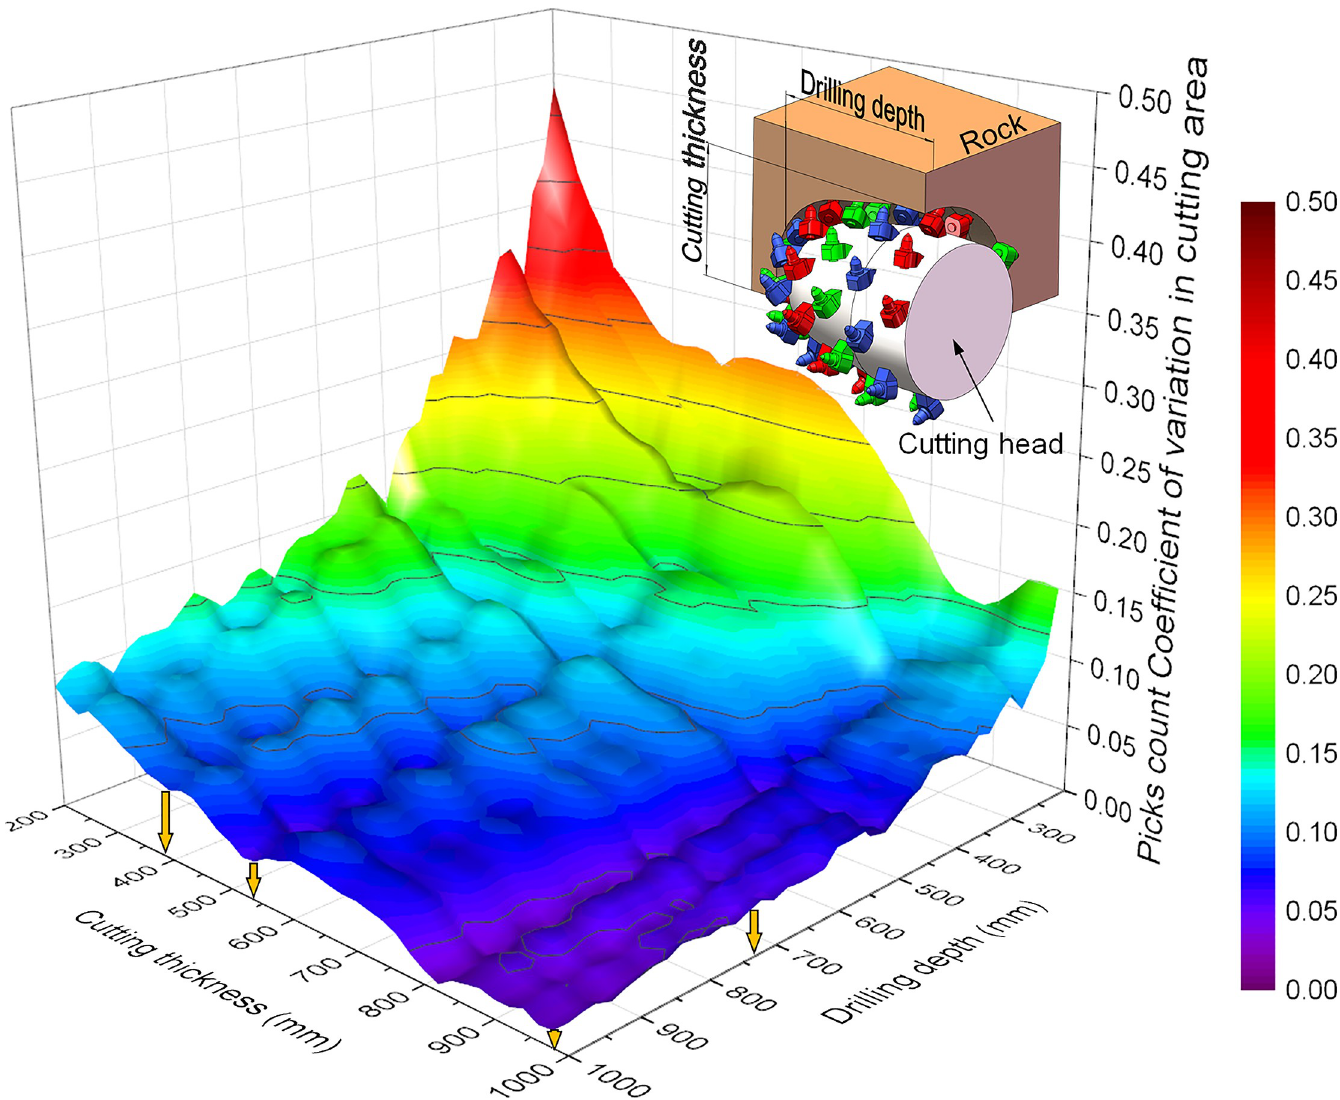
Fig 23. Cutting test parameters determined via drilling depth and cutting